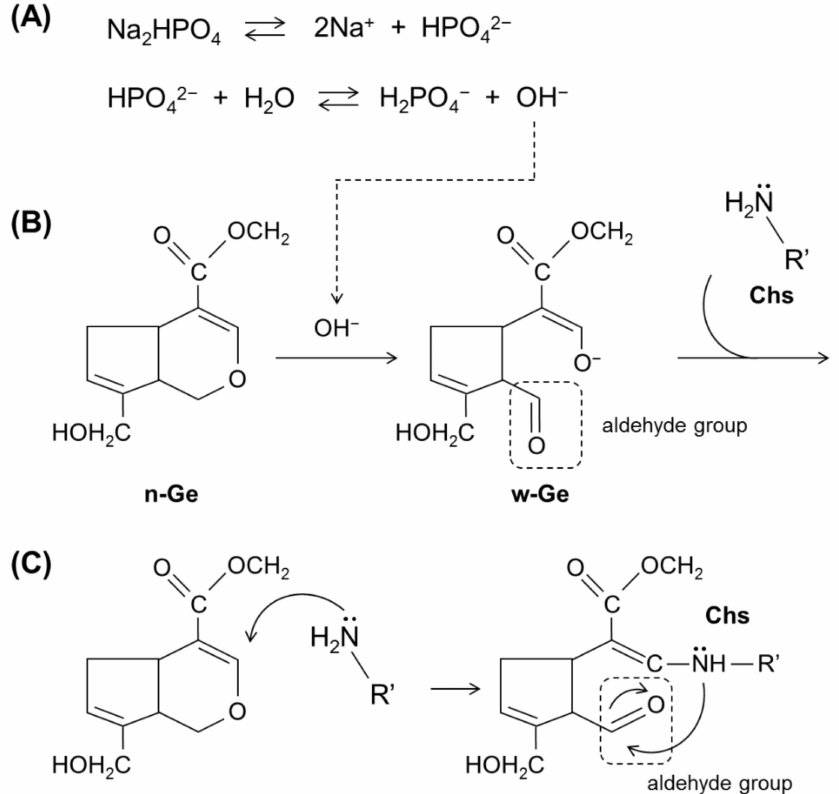
Figure 7. Presumed mechanism of initiation for genipin-induced crosslinking between biopolymers. ( A ) Release of hydroxyl ions from disodium hydrogen phosphate. ( B ) Aldehyde formation